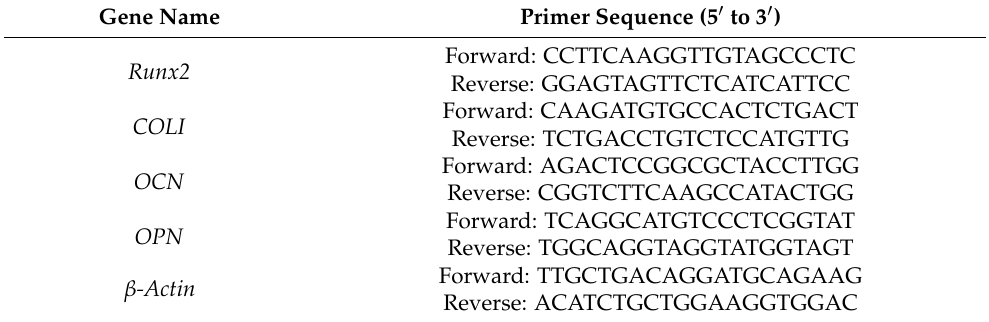
Table 1. Primers sequences used for